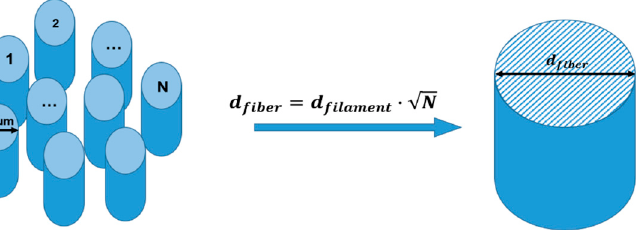
Figure 2. Simplification of the fiber in the 3D electromagnetic simulation by a cylinder with an effective fiber diameter.